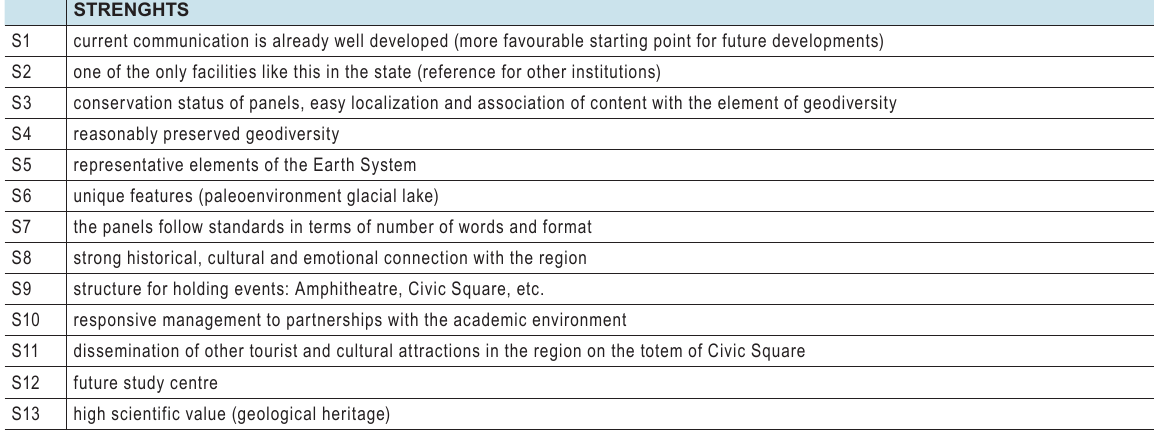
TABLE 7. SWOT Matrix Quadrant 2: